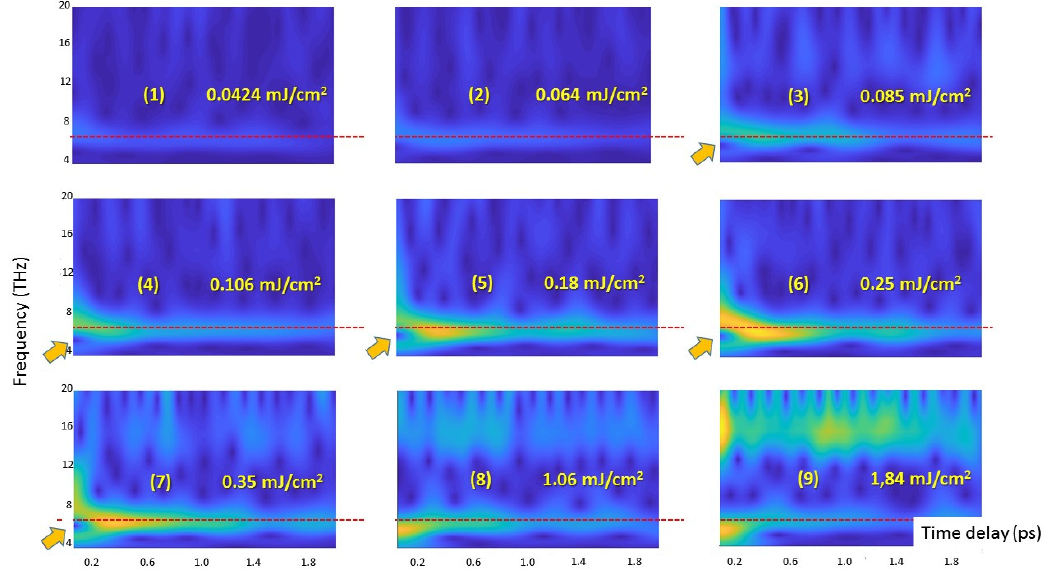
Figure 5. Oscillation intensity distribution by continuous wavelet transform (CWT) in the frequency time domain. Transient traces at the probe wavelength of 567 nm were analyzed. The red dashed line indicates the position of the LO phonon at 6.15 THz as revealed by the Fast Fourier Transform (FFT). Arrows indicate the destructive interference spot. The colormap is the same for all 2D plots revealing the dependence of CWT intensity on pump fluence. Pump fluence: (1) 0.0424 mJ/cm 2 ; (2) 0.064 mJ/cm 2 ; (3) 0.085 mJ/cm 2 ; (4) 0.106 mJ/cm 2 ; (5) 0.18 mJ/cm 2 ; (6) 0.25 mJ/cm 2 ; (7) 0.35 mJ/cm 2 ; (8) 1.06 mJ/cm 2 ; (9) 1.84 mJ/cm 2 .